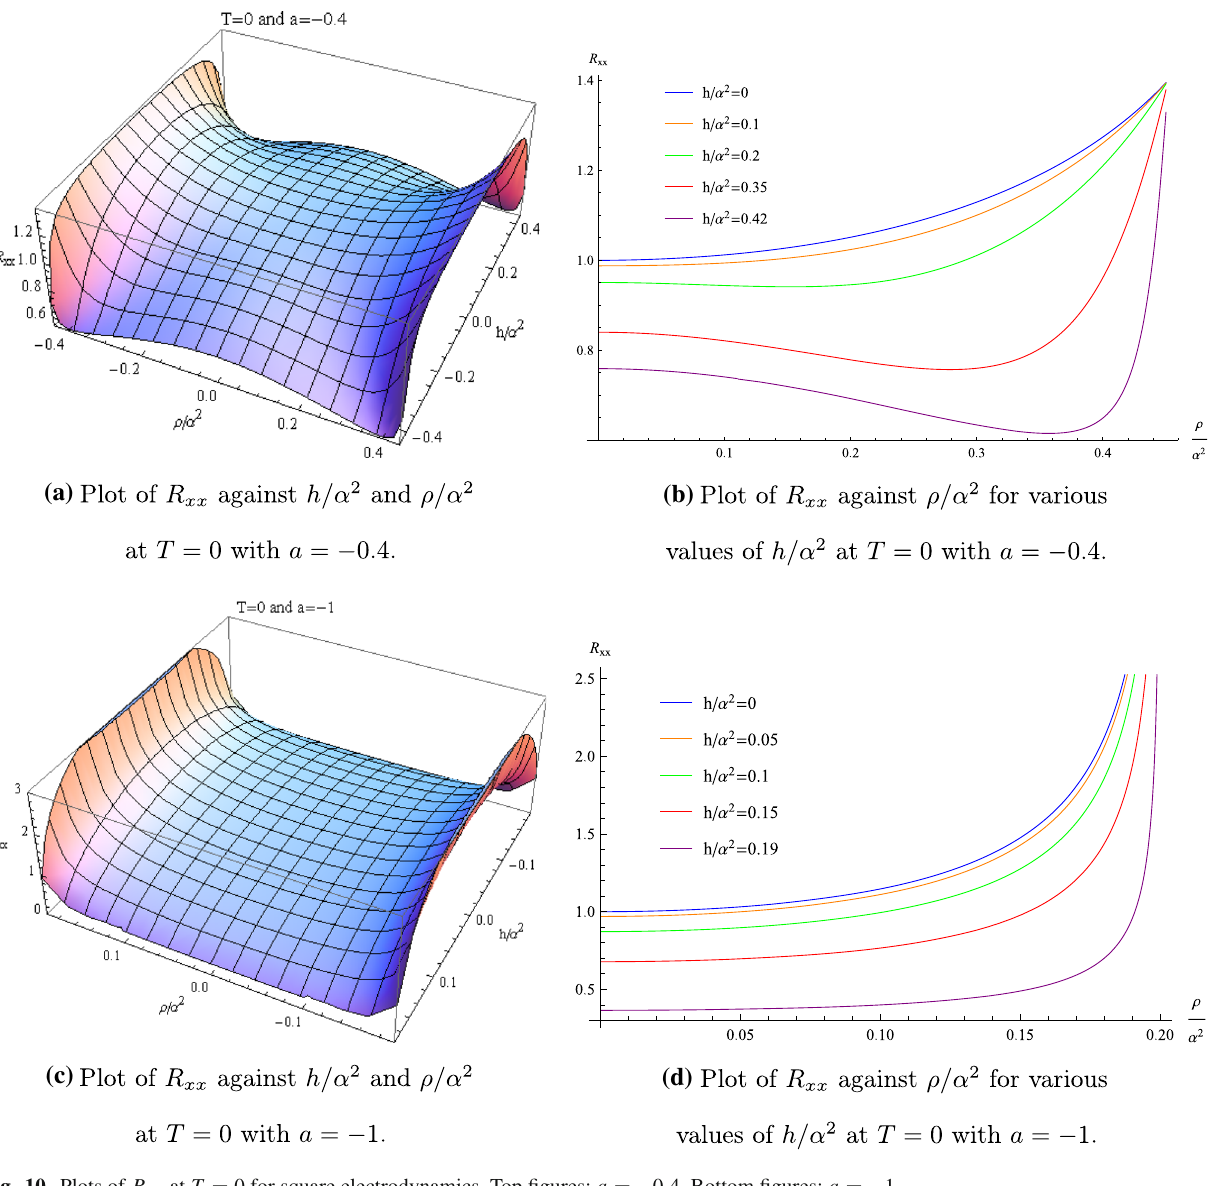
Fig. 10 Plots of R xx at T = 0 for square electrodynamics. Top figures: a = − 0 . 4. Bottom figures: a = −